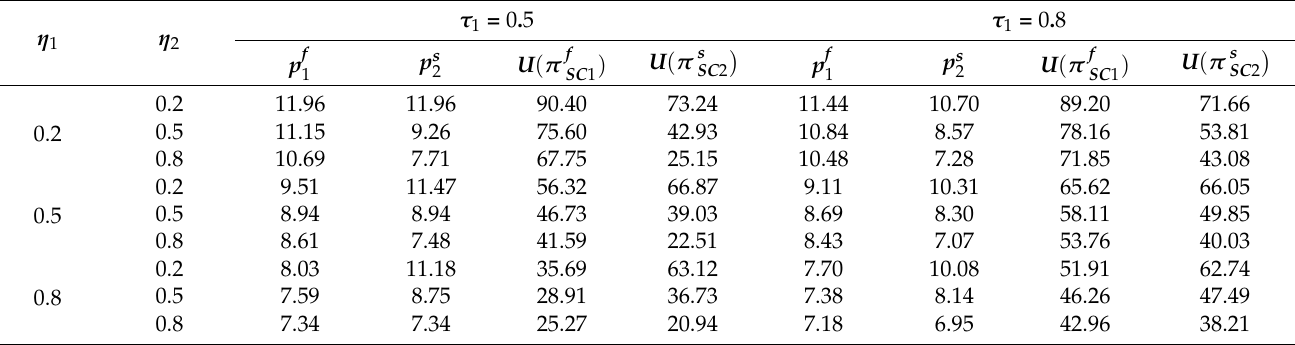
Table 4. Pricing and total expected utility of the two supply chains in the second